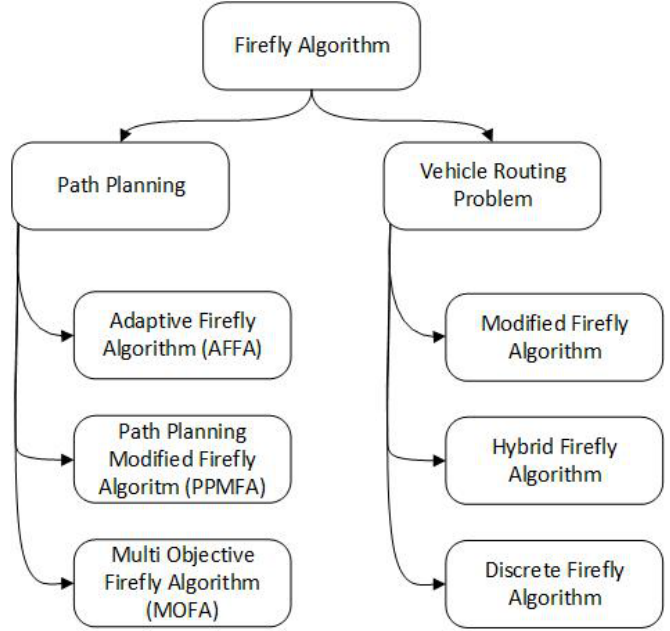
Figure 5. Variants of Firefly algorithm usage, adapted from